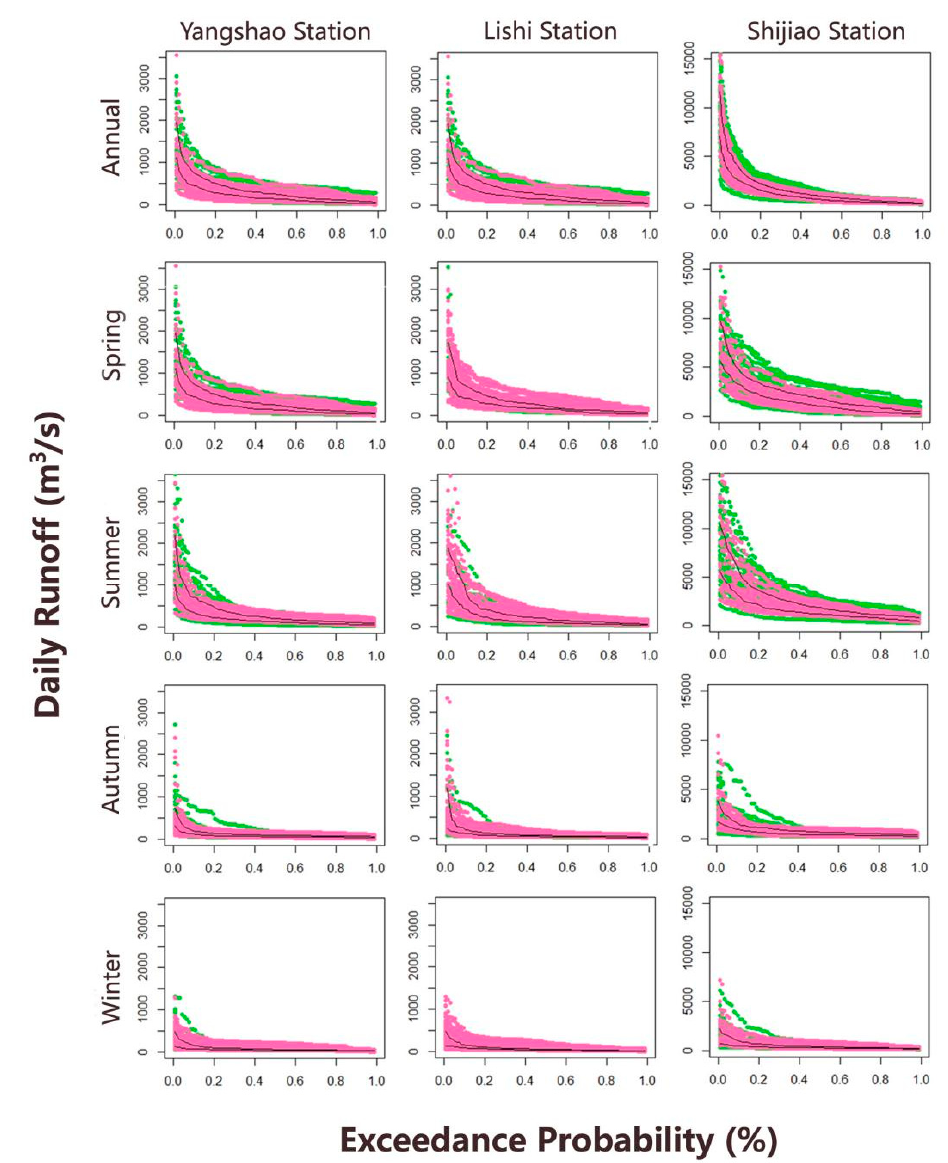
Figure 2. Prior (green curves) and posterior (pink curves) flow duration curves (FDC) due to the construction of reservoirs. Two black lines mean the 25% and 75% FDCs of the prior flow component (green spots). The ecosurplus means the difference values of the flow component over 75% FDC line, and the ecodeficit means the difference values below 25% FDC line.